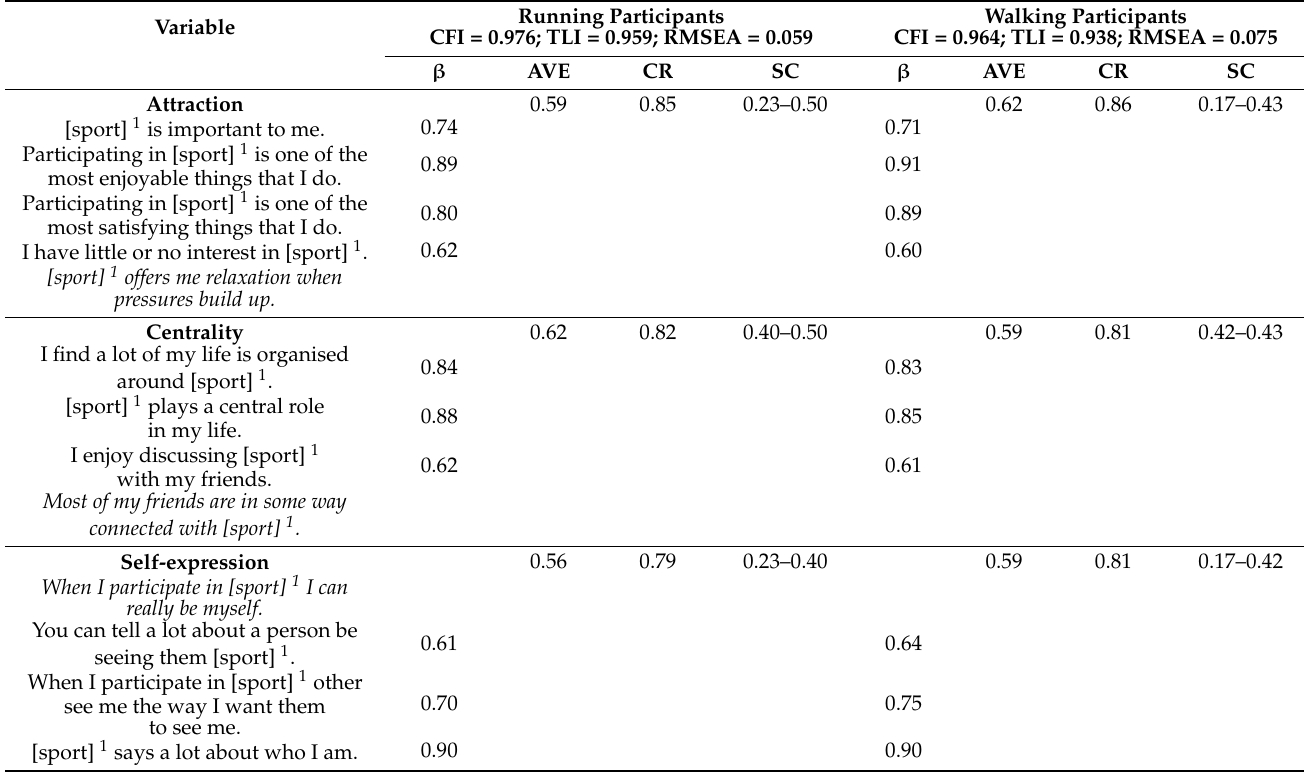
Table 1. Confirmatory factor analysis of involvement in